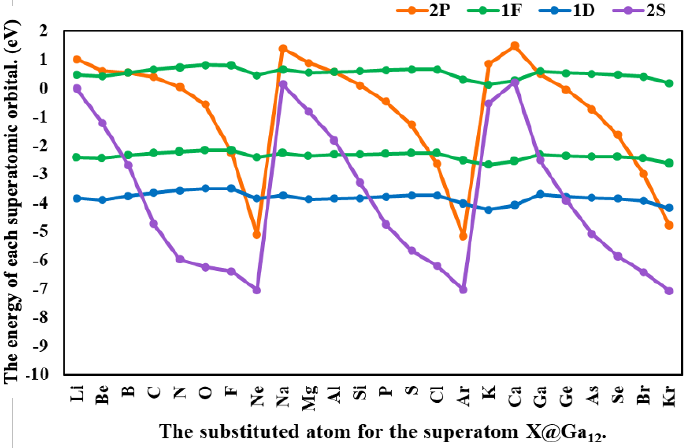
orbitals, respectively, in the X@Ga 12 cluster (interatomic X – Ga bond distance is 2.547 Å ).